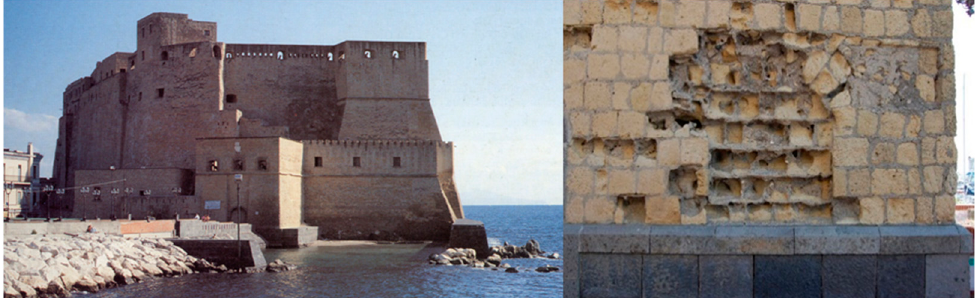
Figure 11. Example of the marked physical weathering of facia vista Neapolitan Yellow Tuff dimension stones, consisting of a marked consumption of their exposed surface assuming a typical concave shape (Castel dell’ Ovo, center of Naples, left: whole building, right: physical weathering; picture by A. Langella).